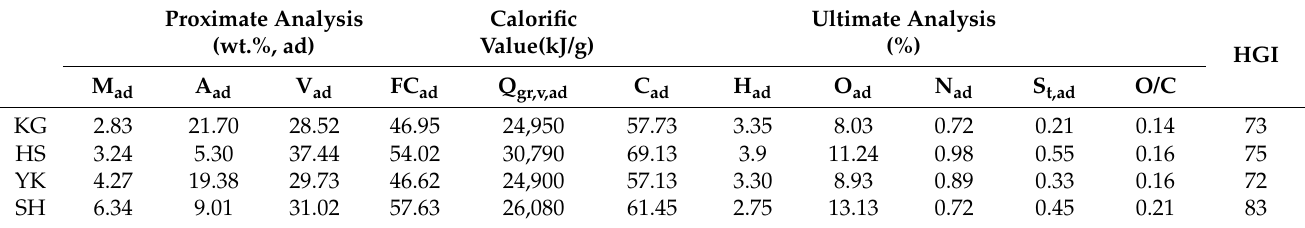
Table 1. Analysis results of Xinjiang low rank